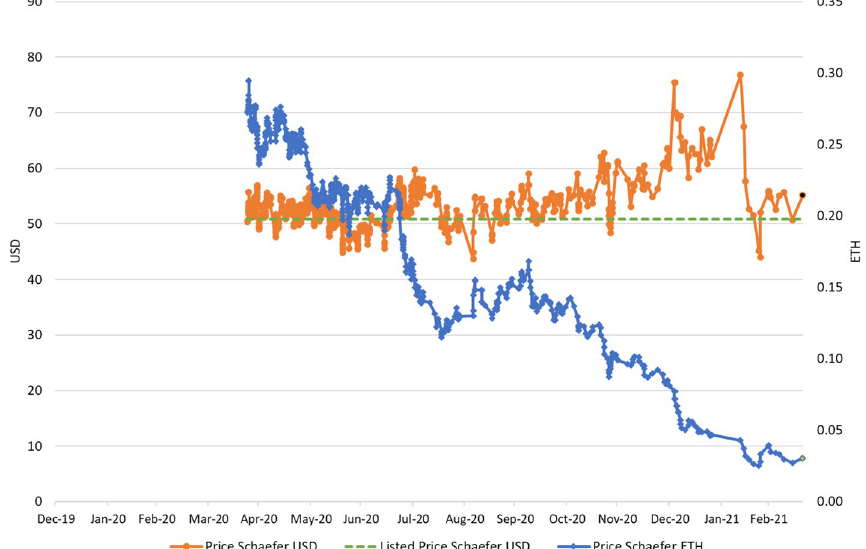
Fig. 16 Price (in USD and ETH) of 8342 Schaefer Highway Detroit MI. Each dot represents one transaction. Last colored dot is ask price on Uniswap